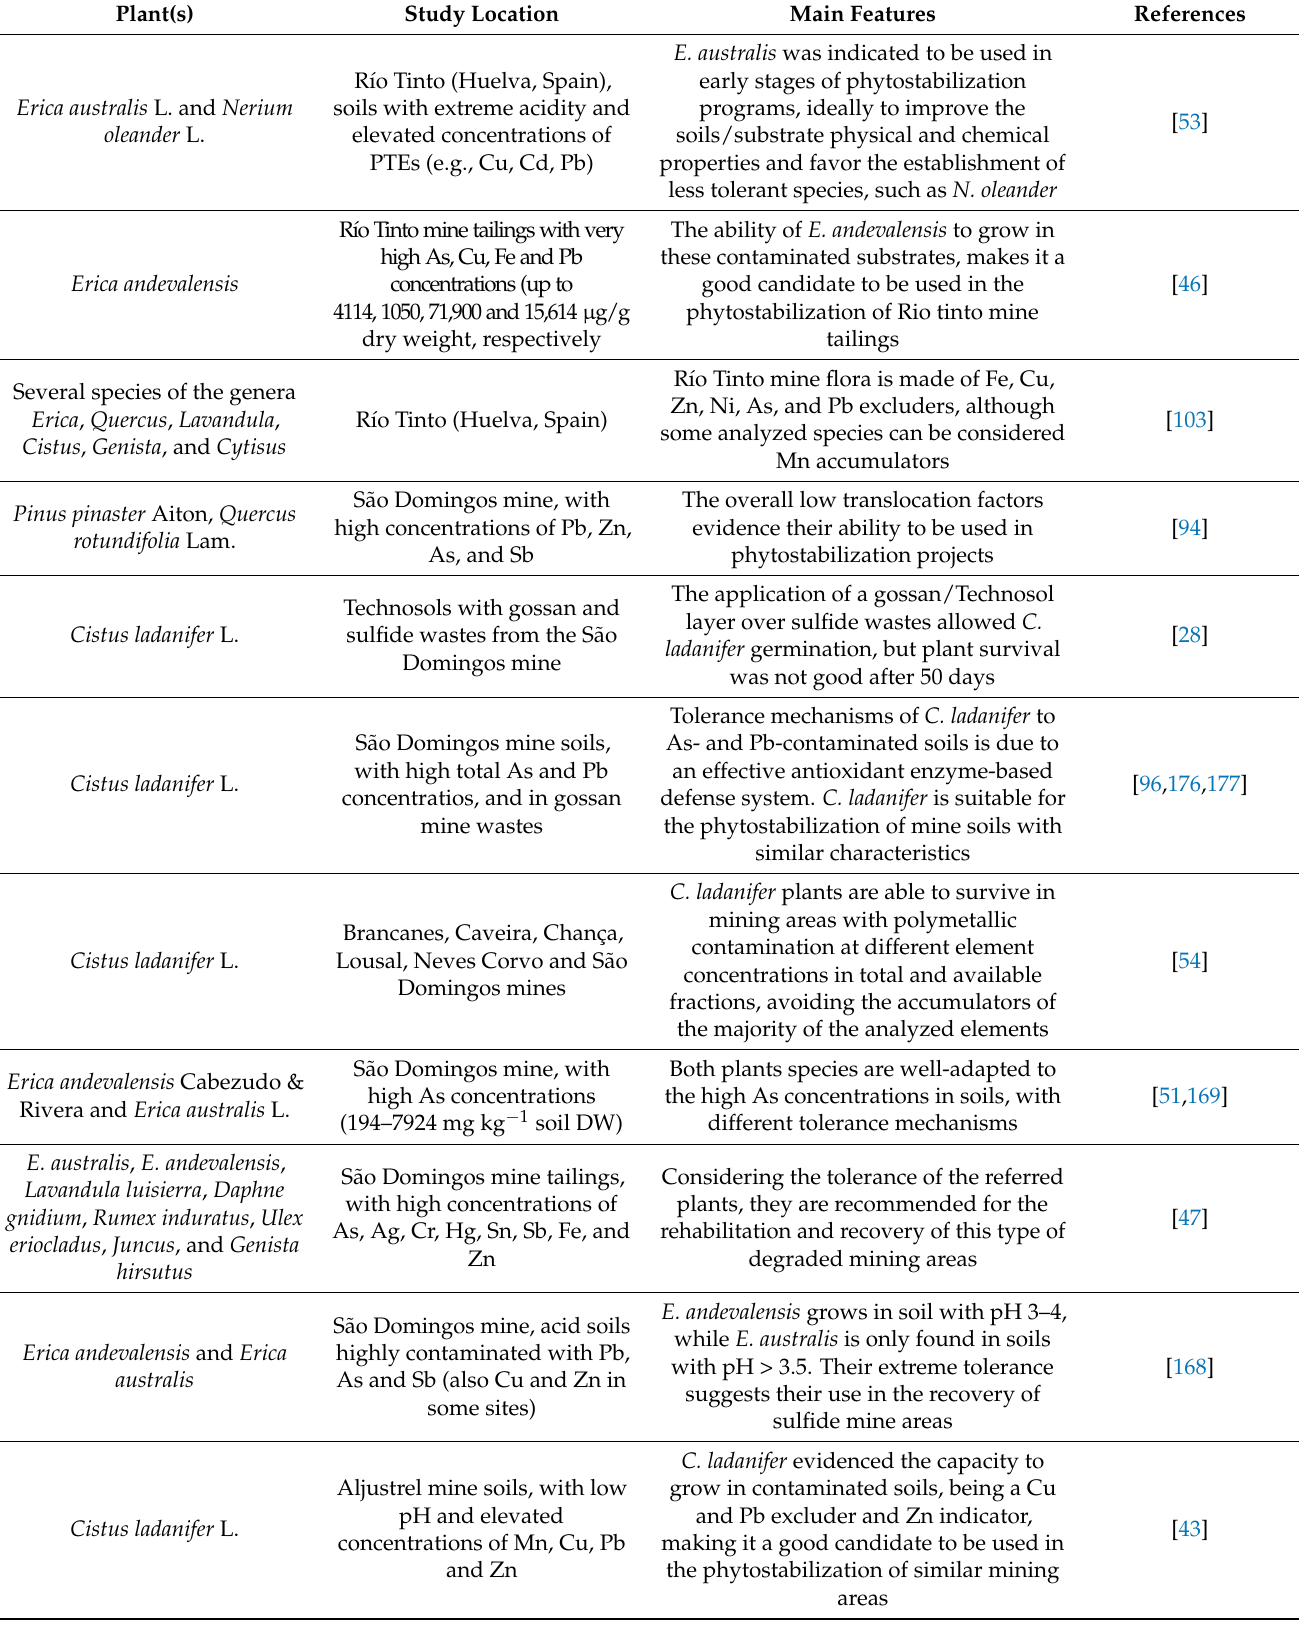
Table 3. Native plant species surveyed or used in some remediation projects in the